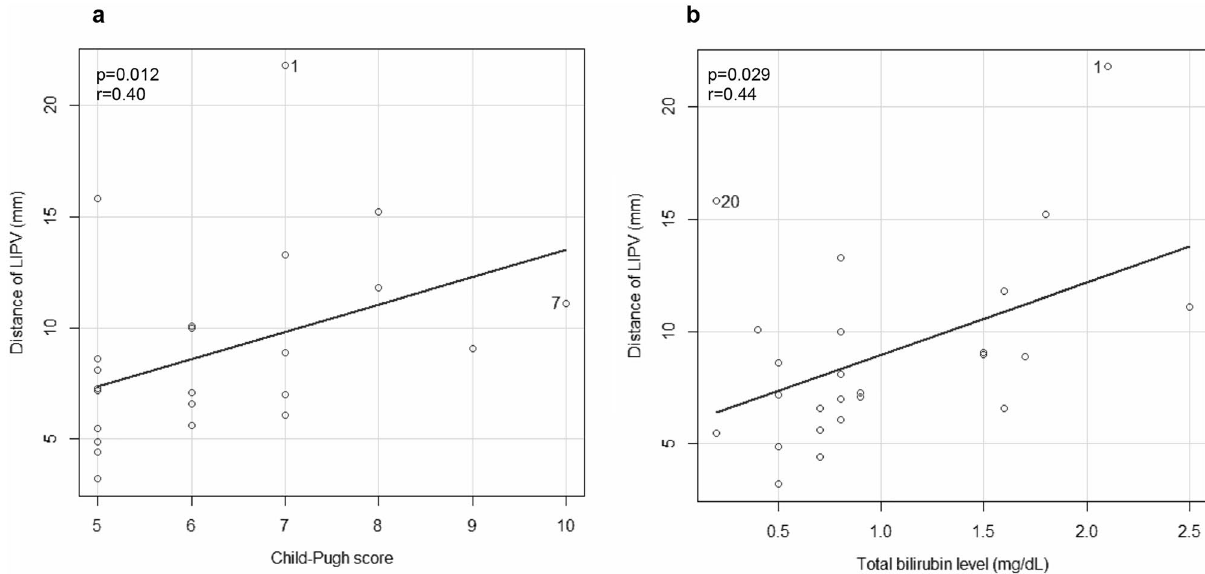
Figure 4. ( a ) Correlation between Child–Pugh score and the diameter of LIPV. The diameter of LIPV was significantly correlated ( p = 0.012) with Child-Pugh score. The correlation coefficient was r = 0.40. ( b ) Correlation between total bilirubin level and the diameter of LIPV. The diameter of LIPV was significantly correlated ( p = 0.029) with total bilirubin levels. The correlation coefficient was r =